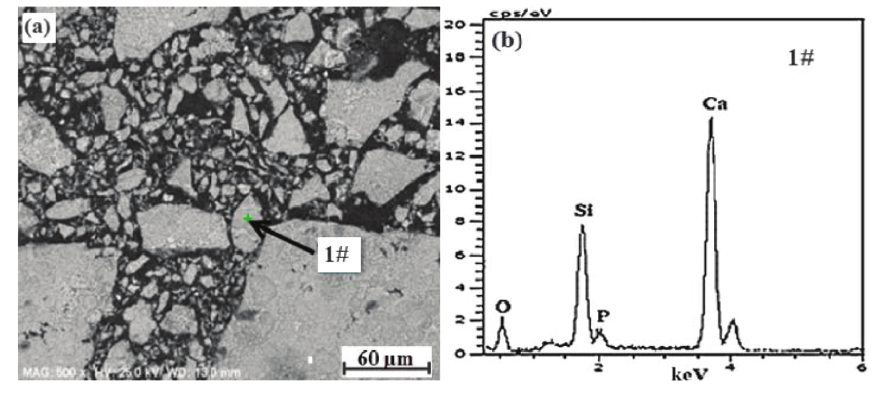
Figure 4: SEM images and EDS analysis results of the first deslagging of 1# heat: (a) SEM image, (b) EDS